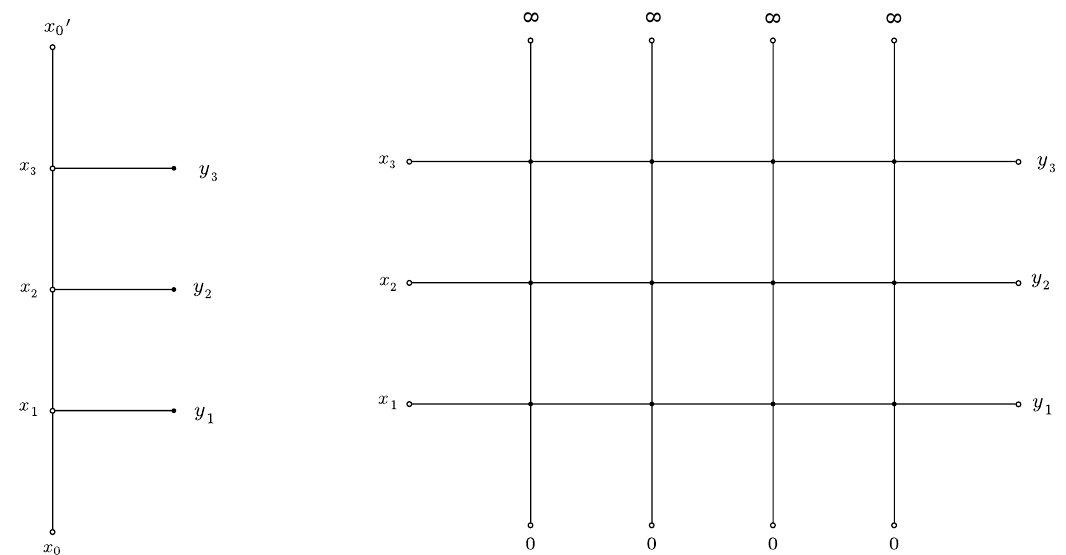
Figure 1 . Left: graph-building operator for a fishnet integral of size N = 3 , with fixed boundaries x 0 and x 0 . Solid lines are bare propagators. Right: fishnet integral of size M × N with M = 4 0 and N = 3 . The boundaries are fixed to points x 0 = 0 and x 0 for which the graph-builder is especially simple to diagonalise. The Basso-Dixon integral would correspond to a reduction x k = x and y k = y . Black dots are integrated vertices and circles are external